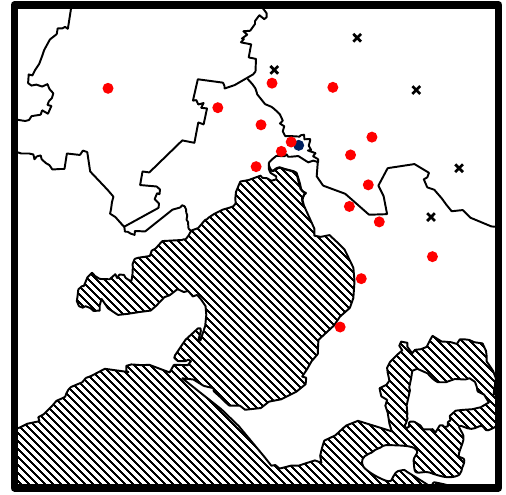
Figure 1. Drinking water sample locations (dots) and the water treatment plants (crosses) that distribute drinking water to suburban Melbourne (Victoria, Australia). Bordered areas are the sectors serviced by the main water utilities in Melbourne.